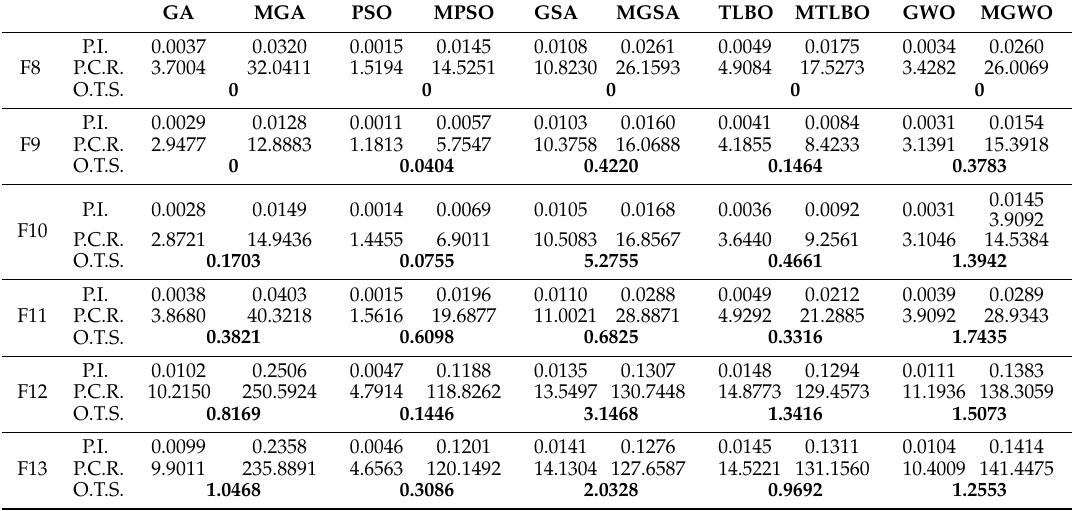
Table 8. Computational time analysis on multimodal objective functions (second).